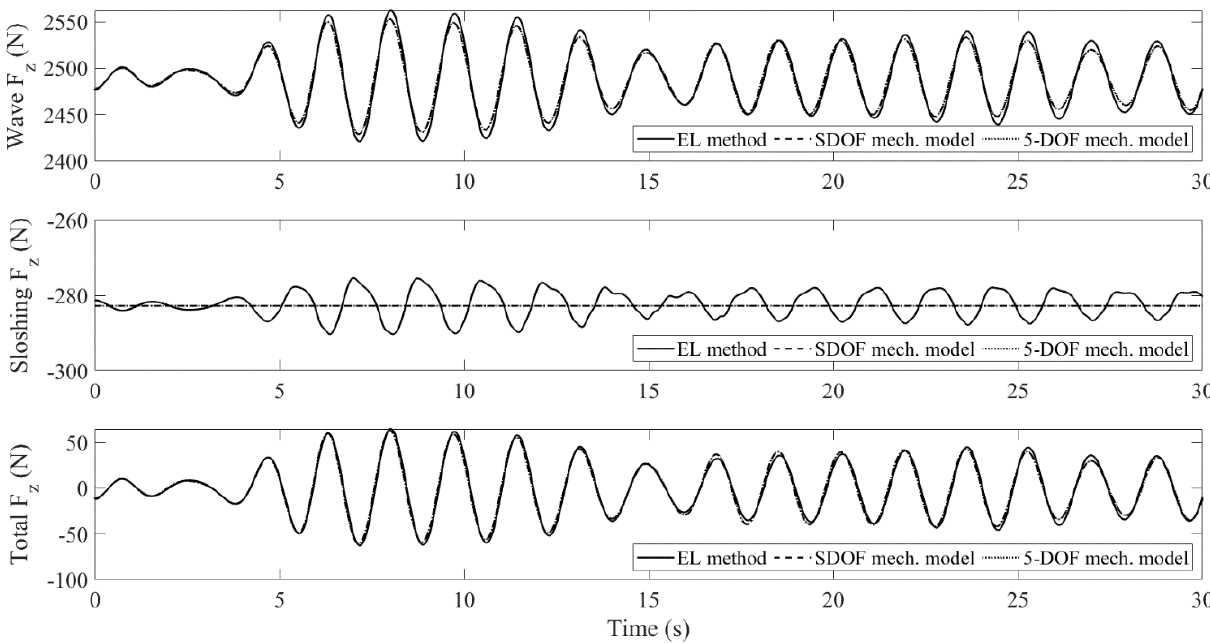
Figure 16. The heave motion responses of the floating body, configured with a water tank installed with porous media, undergoing small wave excitation.